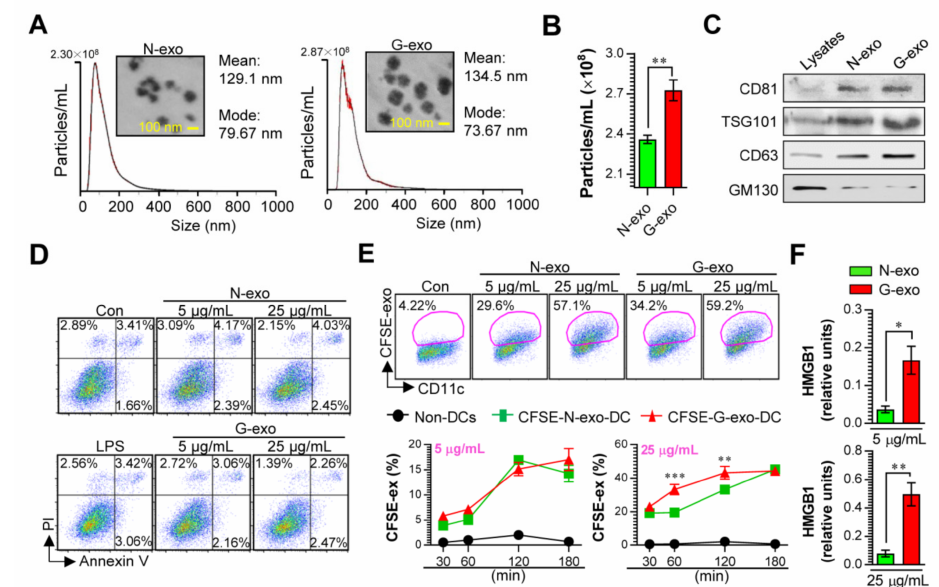
Figure 1. Analysis of the cytotoxicity, cellular uptake, and HMGB1 levels of N-exo and G-exo. Particle sizes ( A ; histograms) and numbers ( B ) of exosomes (N-exo and G-exo) purified from non- and gamma-irradiated B16 / BL6 melanoma cancer cells were analyzed by the NTA system ( n = 3 samples). ( A ; photo) TEM image of purified N-exo and G-exo. ( C ) The expression of exosomal markers such as CD81, TSG101, and CD63 were determined using western blot. GM130 is a negative marker of exosomes. ( D ) BMDCs were stimulated with LPS (100 ng / mL), N-exo (5 and 25 µ g / mL) and G-exo (5 and 25 µ g / mL) for 18 h, and respective cytotoxicities were measured using flow cytometry with Annexin V / PI staining ( n = 3). ( E ) BMDCs were stimulated with CFSE-labeled N-exo and G-exo for indicated time periods and cellular uptake levels (CFSE + CD11c + cells) of CFSE-labeled exosomes were analyzed by flow cytometry ( n = 4 per time period). ( F ) HMGB1 levels were analyzed using ELISA in concentrations of 5 and 25 µ g / mL of N-exo and G-exo ( n = 3). * p < 0.05, ** p < 0.01, *** p <